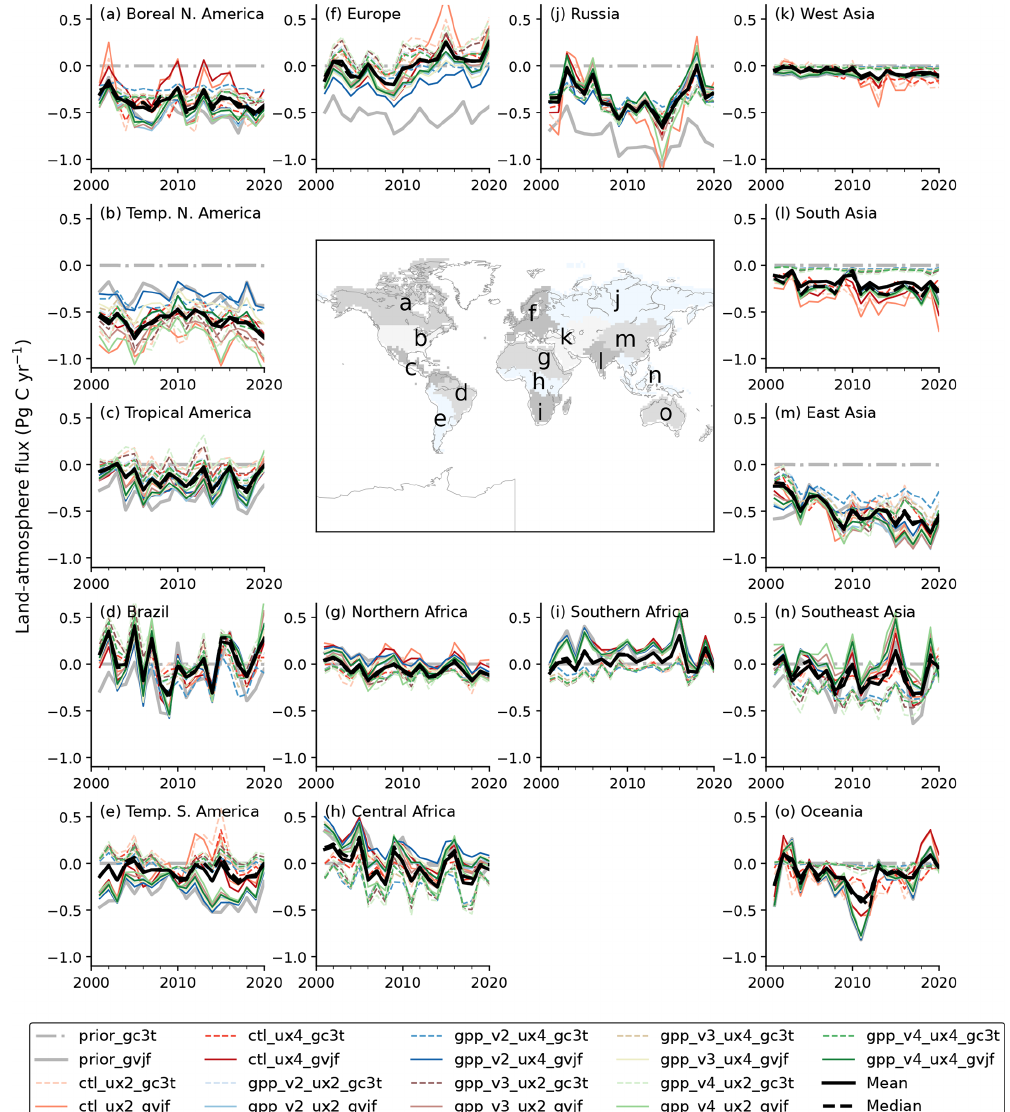
Figure 6. Interannual variation of terrestrial land CO 2 fluxes derived from 16 sets of inversion. The variations are shown for 15 aggregated regions shown in the map. The negative values are counted as CO 2 removals from the atmosphere, while CO 2 emissions are counted